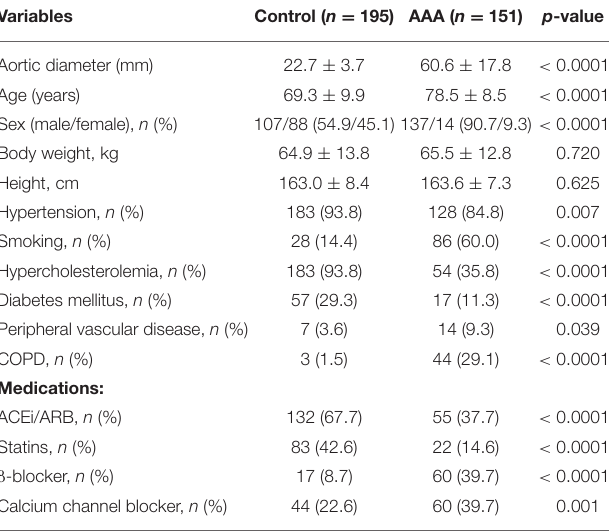
TABLE 1 | Clinicodemographic characteristics of control patients and patients with AAA.